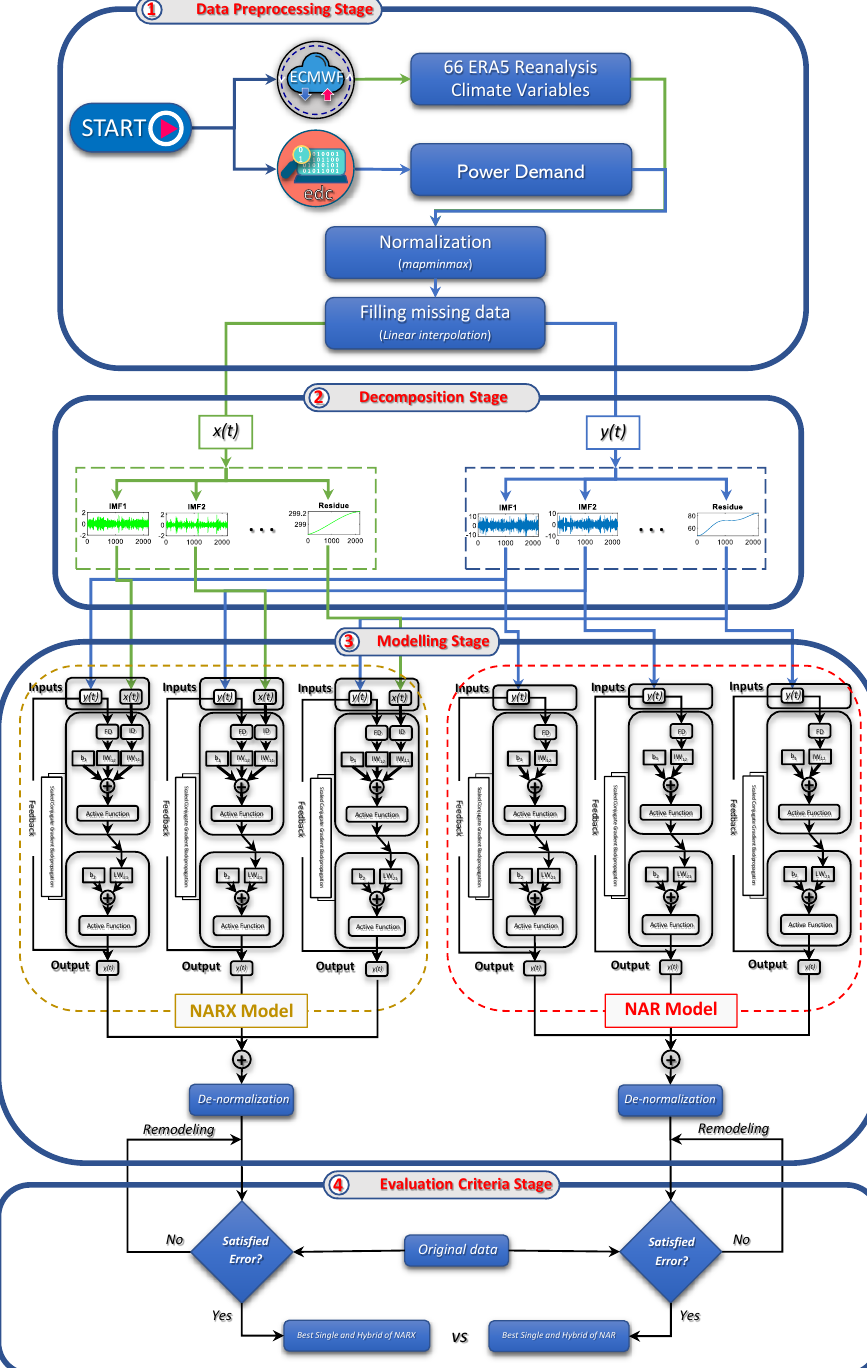
Figure 4. Structures of the NARX and NAR models. The NAR and NARX models have basically the same structure, but the NAR model has no exogenous inputs.